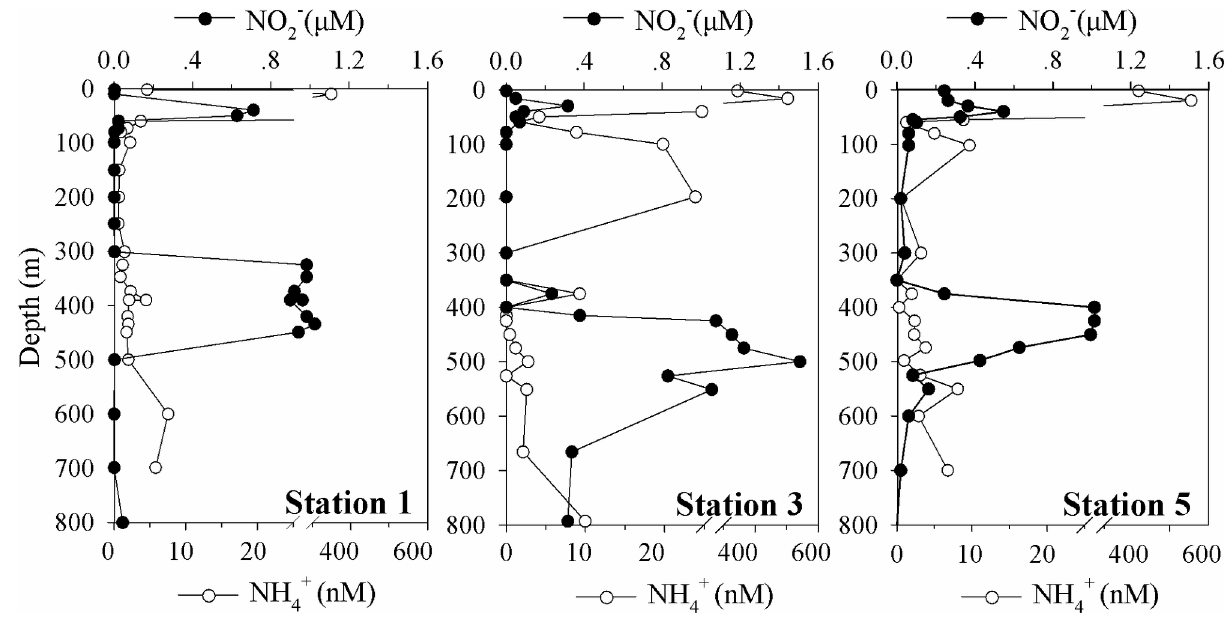
Figure 3. Vertical distributions of nitrite (NO 2- ) and ammonium (NH 4+ ) in the water columns of the sampling stations in Costa Rica Dome (CRD).